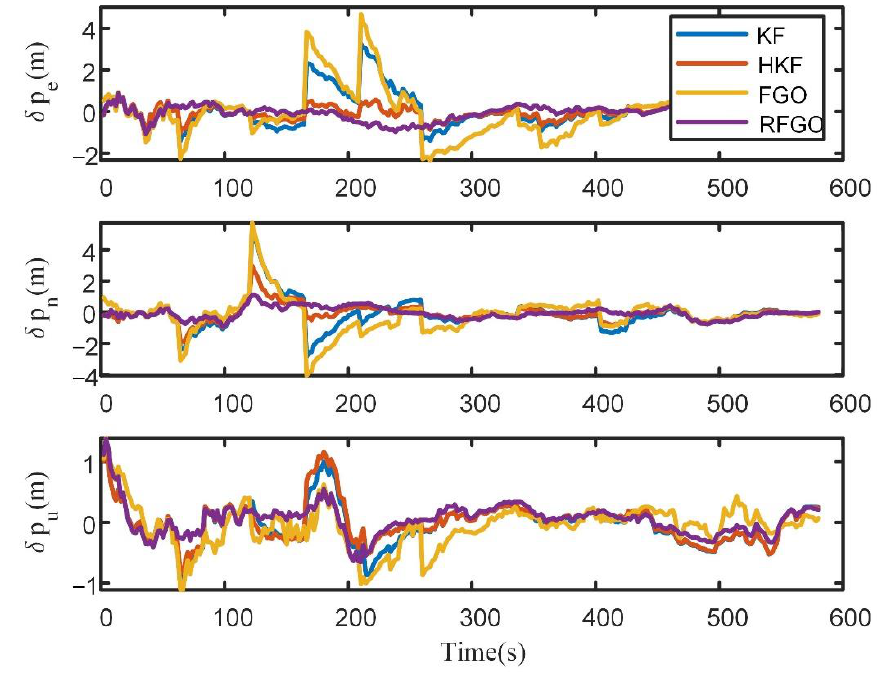
Figure 4. Position error of different algorithms.